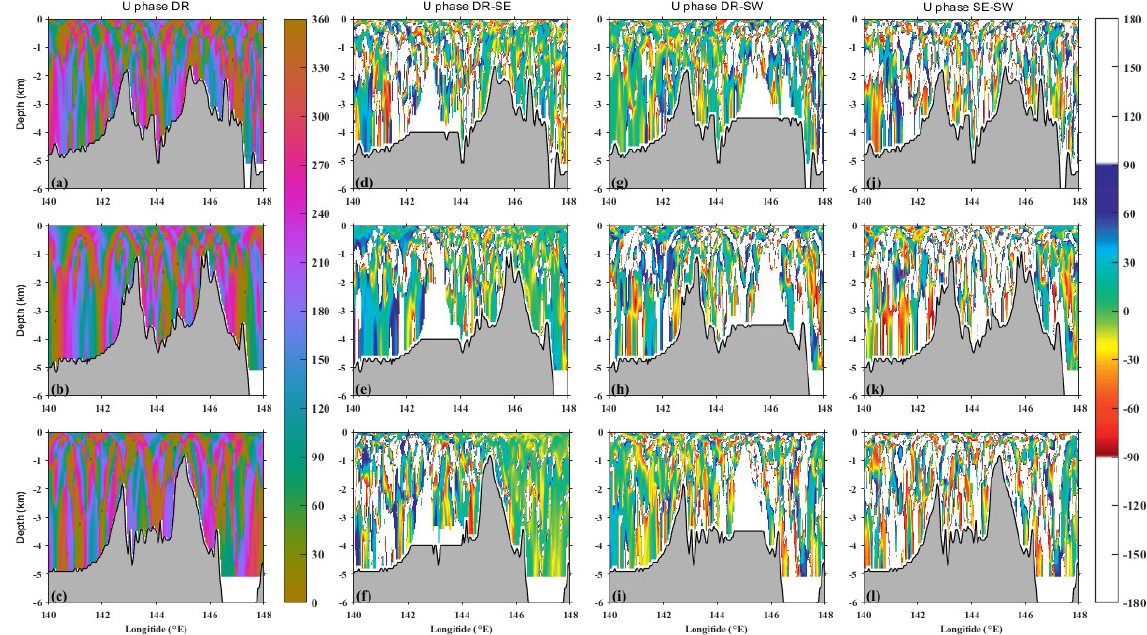
Figure 7. The phase (degree) of the internal tidal zonal velocity along the 20° N ( a ), 17° N ( b ), and 14° N ( c ) sections under the DR case. The phase difference (degree) between the DR and SE cases (DR-SE) along 20° N ( d ), 17° N ( e ), and 14° N ( f ). The phase difference (degree) between the DR and SW cases (DR-SW) along 20° N ( g ), 17° N ( h ), and 14° N ( i ). The phase difference (degree) between the SE and SW cases (SE-SW) along 20° N ( j ), 17° N ( k ), and 14° N ( l ). Gray shaded areas represent topography along the sections.